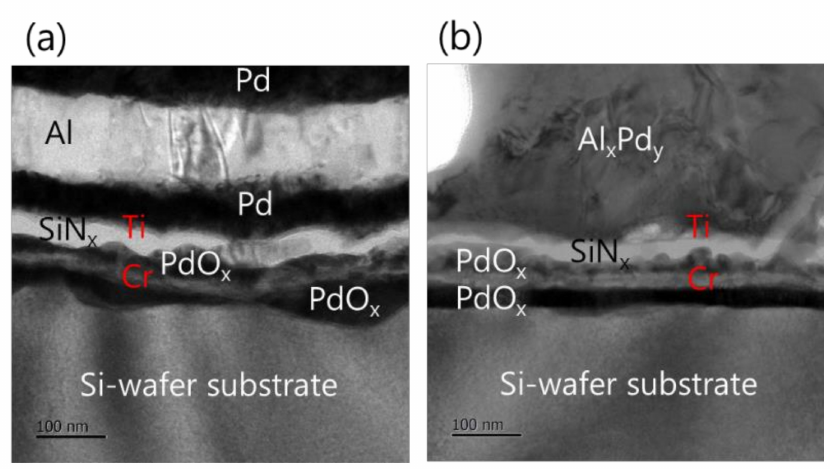
Figure 8. TEM images showing the interface structure configuration of the iRMS grown on a PdO x - buffered Si-wafer. ( a ) As-deposited RMS; ( b ) After reaction